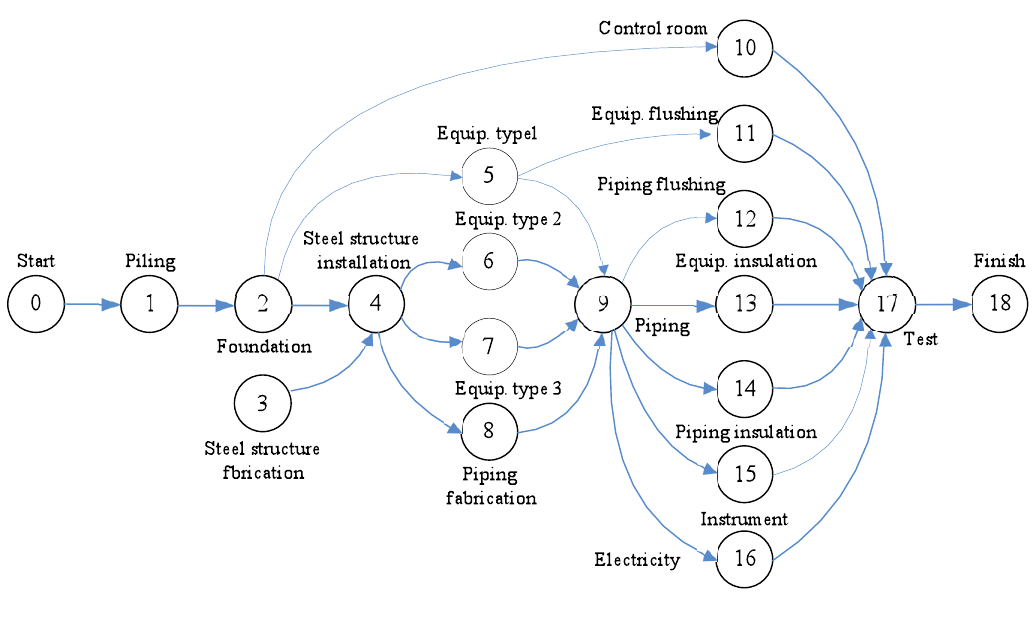
Figure 4. “Project network of petrochemical plant